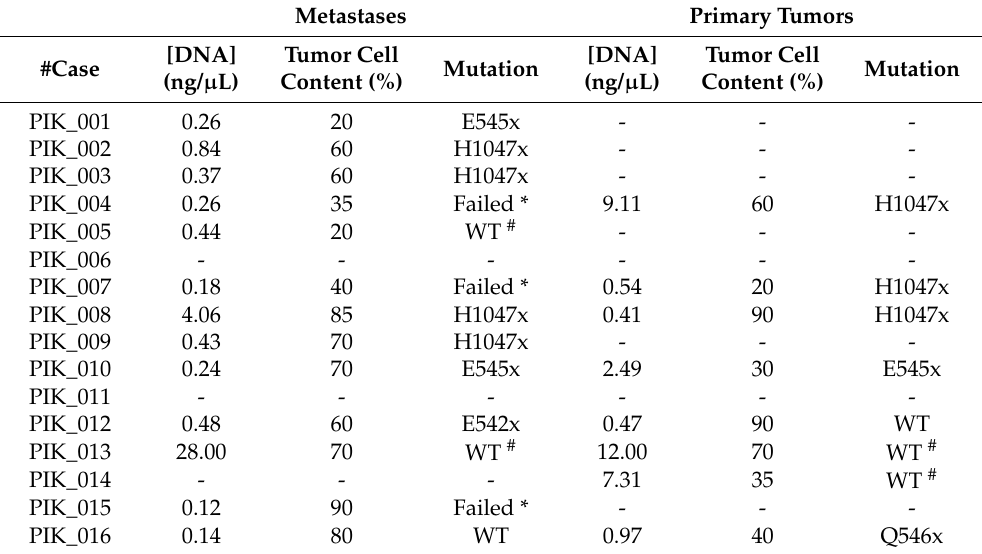
Table 4. Summary of the PIK3CA mutations detected using RT-PCR on primary tumor and metastasis samples. Mutations are annotated according to the amino acid change; WT, wild-type; # mutation out of the EasyPGX reference range; * Failed due to low DNA quantity but mutation visible in the individual